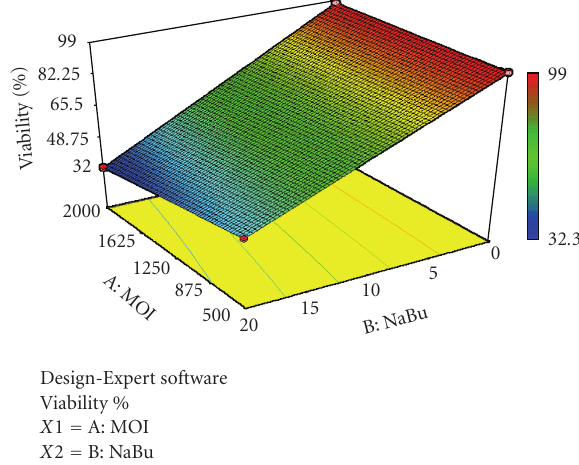
Figure 4: The e ff ect of MOI and NaBu concentration on cell viability. The graph was generated using ANOVA analysis software (Stat-Ease Design Expert). Three-dimensional surface view of numerical optimization graph shows the cell viability.